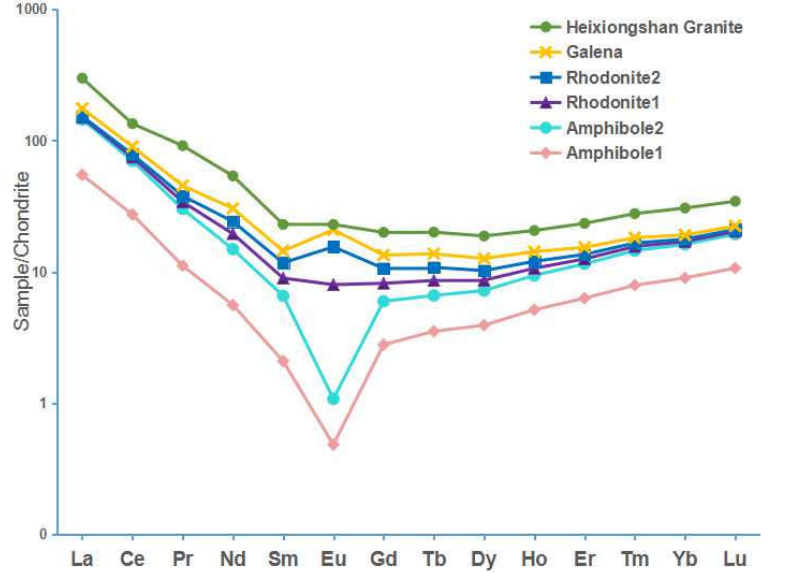
Figure 9. REE patterns of the mineral in JingFenCui deposit (c1 chondrite normalization values after Boynton, 1984